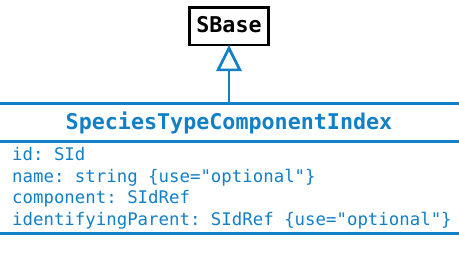
Figure 6: The definition of the SpeciesTypeComponentIndex